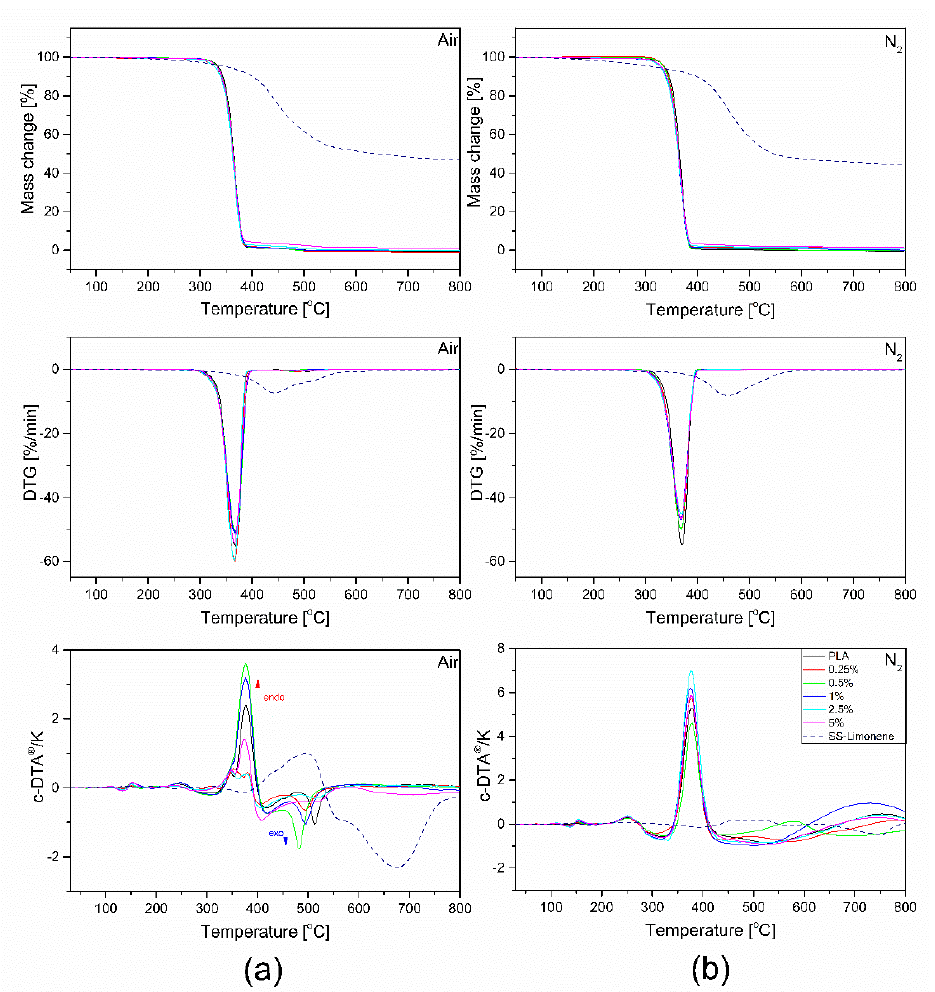
Figure 7. TGA, c-DTA and DTG curves of SS-Limonene / PLA composite in ( a ) air and ( b ) nitrogen atmosphere. Table 2. Results of thermogravimetric analysis.